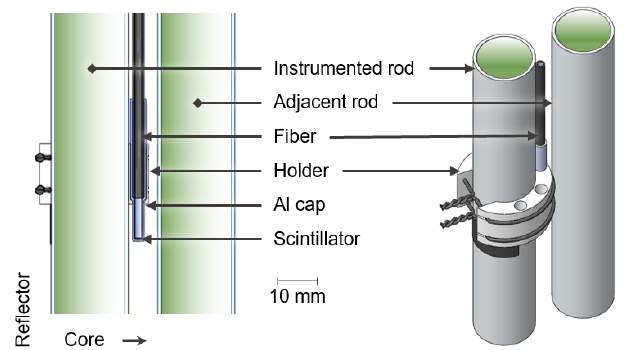
Fig. 4. East-West cross section and 3D view of the positioning of the miniature scintillator on one of the outmost fuel rods of COLIBRI (A2), with respect to its adjacent one